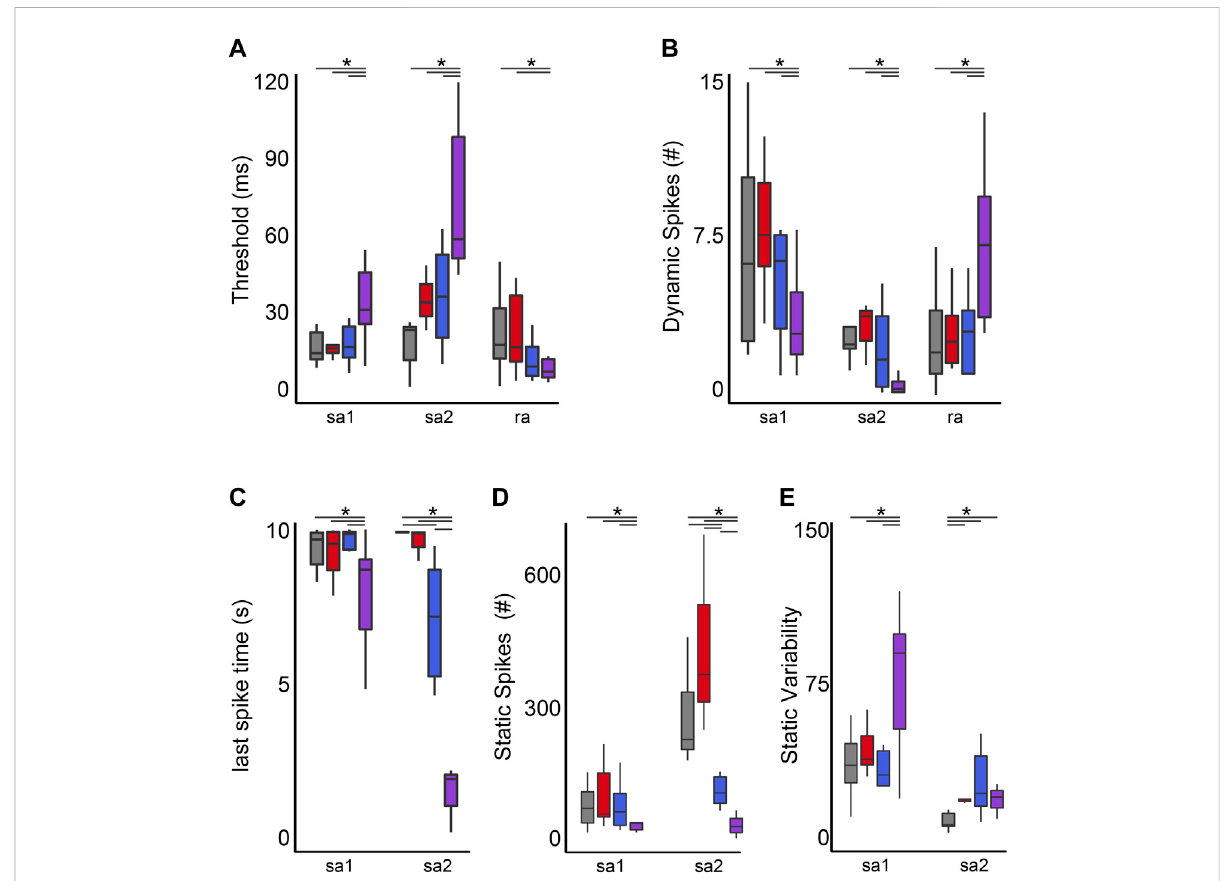
FIGURE 6 Co-Impairment of Key Cutaneous Mechanosensory Features. Quanti fi cation of clusters of encoding parameters: detection threshold (A) , dynamic spikeencoding (B) lastspiketime (C) ,numberofspikesduringstatic (D) andspikevariabilityduringstaticstimuluspresentation (E) averaged from four trials, from each neuron in each of the neuronal classes. * indicates statistically signi fi cant differences as empirically derived from hierarchical Bayesian model (stan_glm): 95% highest density intervals do not